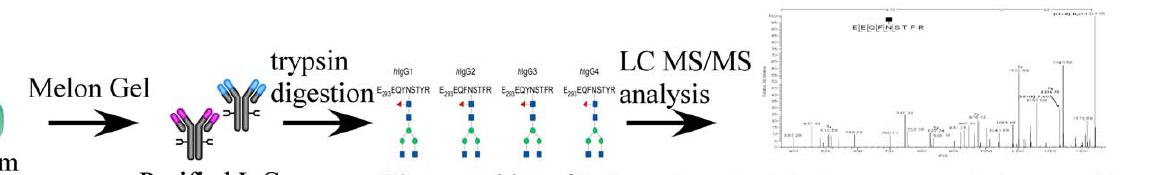
Figure 5. Use mass spectrometric identification and glycoform profiling of the IgG glycoforms and AAL-reactive IgG. (A) Scheme of the procedure (see details in Experiment and Methods Section); (B) A total ion chromatograph of a purified rabbit IgG; (C) A mass spectrum of the sample at retention time 19 minutes; (D) and (E) Extracted ion chromatographs of G0F, and G0, respectively. (F) MS/MS spectrum of G0 IgG.